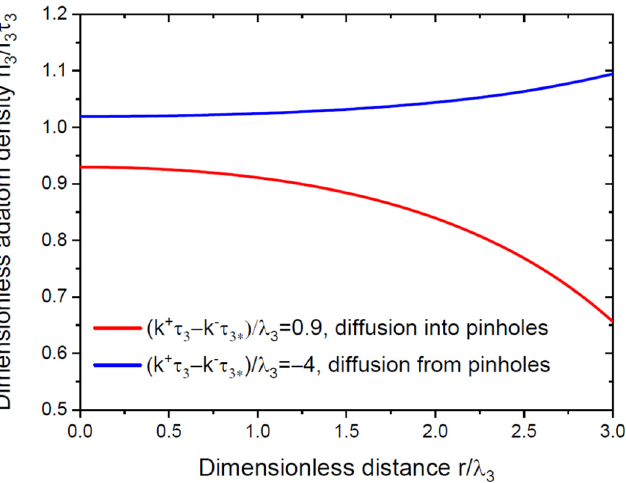
Figure 2. Dimensionless group III adatom density on the mask versus dimensionless distance 𝑟 𝜆 (cid:2871) ⁄ , decreasing toward the pinhole periphery at 𝑘 (cid:2878) 𝜏 (cid:2871) (cid:3408) 𝑘 (cid:2879) 𝜏 (cid:2871)∗ , and increasing